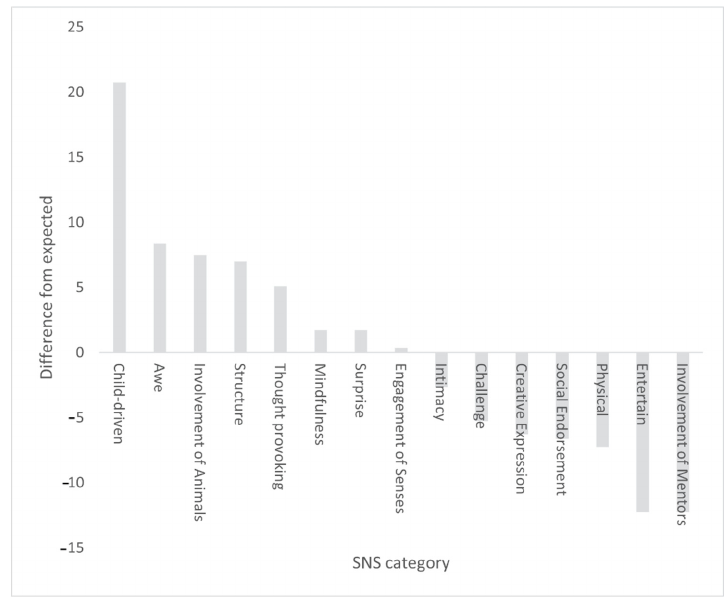
Figure 6. Difference in number of submissions observed from expected between SNS